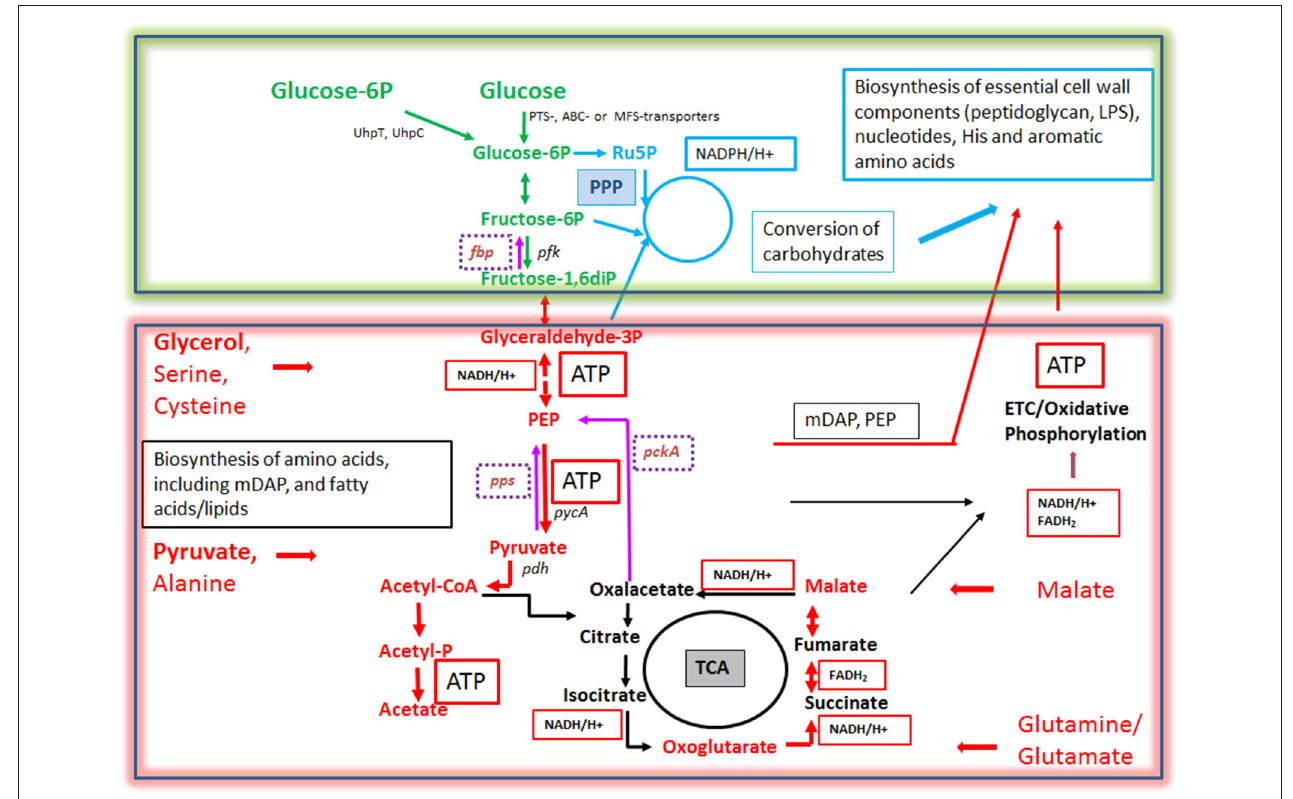
FIGURE 6 | Bipartite metabolism of IBPs aiming to avoid the exclusive use of glucose (an indispensable carbon source of their mammalian host cells) by the IBPs for their intracellular metabolism. This strategy divides the bacterial carbon metabolism into two modules. Module 1 (green-framed), contains the upper (energy-dependent) part of the glycolytic pathway, as well as the oxidative and non-oxidative arms of PPP. These metabolic pathways are fed mainly by glucose, glucose-6P or polymers (e.g., glycogen) yielding these hexoses and deliver intermediates essential for the (energy-dependent) biosynthesis of cell envelope components, nucleotides, aromatic amino acids and NADPH, a co-factor essential for several biosynthetic pathways (especially fatty acids/lipids). The synthesis of certain cell envelope components and NADPH is indispensable for intracellular growth of the IBPs while all other components, including aromatic amino acids and nucleotides produced in module 1 can be also provided by the host cell (see Figure 3 ). Module 2 (red-framed) comprises the lower part of glycolysis, the TCA cycle and electron transport chain (ETC). Module 2 can be fed by C 3 -carbon sources, such as glycerol-(3P), serine, cysteine and pyruvate, by glutamine/glutamate and possibly by TCA intermediates, e.g., malate. It delivers mainly ATP by (a) substrate phosphorylation through NAD-dependent oxidation of these carbon sources and (b) by oxidative phosphorylation via ETC which converts NADH back to NAD necessary for maintaining the oxidation of the above carbon substrates. Module 2 delivers also intermediates for the biosynthesis of several amino acids, all of which can be imported from the host cell. Indispensable is, however the production of meso-diaminopimelic acid (mDAP) and PEP for the synthesis of peptidoglycan and of Ac-CoA for the biosynthesis for specific cell-envelope-associated fatty acids/lipids (see Figure 3